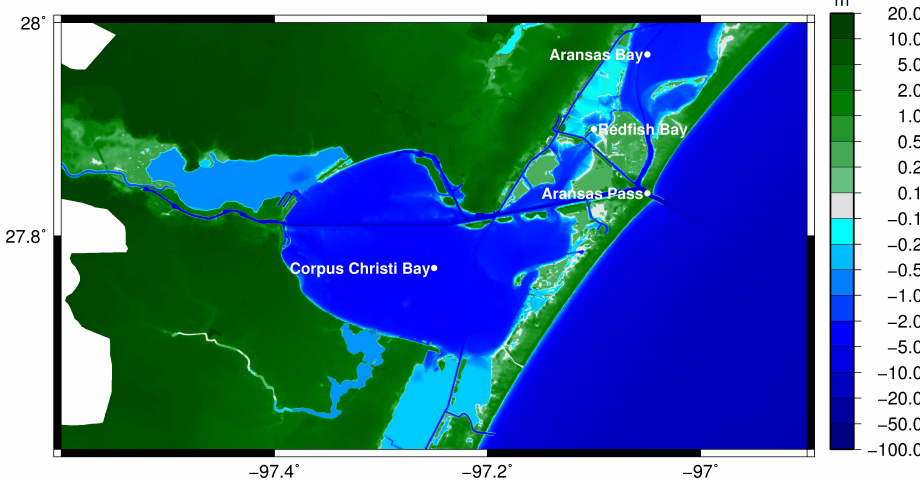
Figure 1. Focus area of present